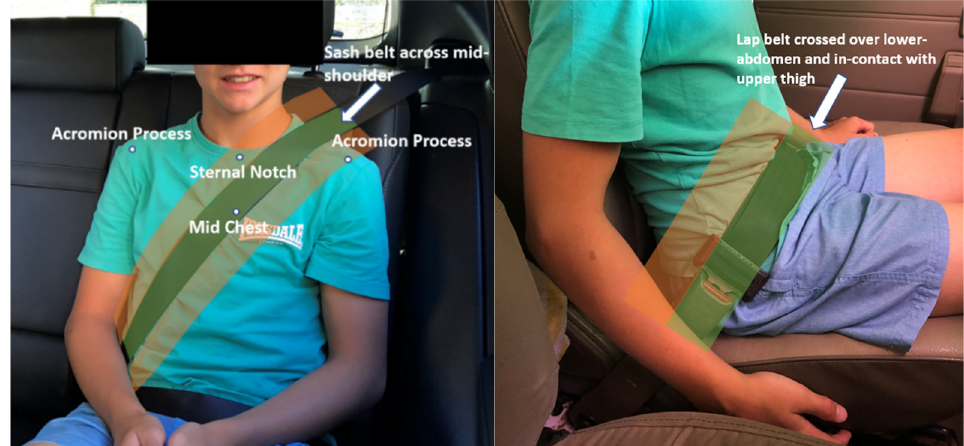
Figure 1. Photographs of a child passenger exhibiting good sash belt fit (sash across mid-shoulder), left, and good lap belt fit (lap belt crossed over lower-abdomen and in contact with upper thigh), right. The green shading indicates the belt position for a good fit and red shading indicates the belt position for a poor fit.